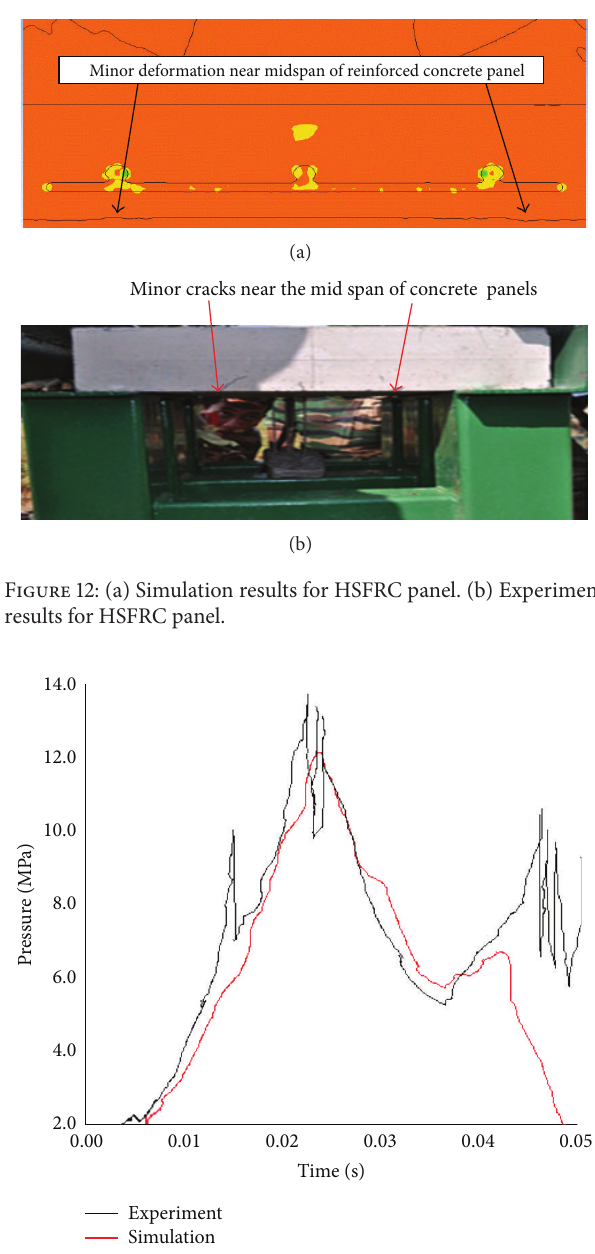
Figure 13: Result for peak overpressure resulted from 1kg of plastic explosive at 0.3 meter standoff